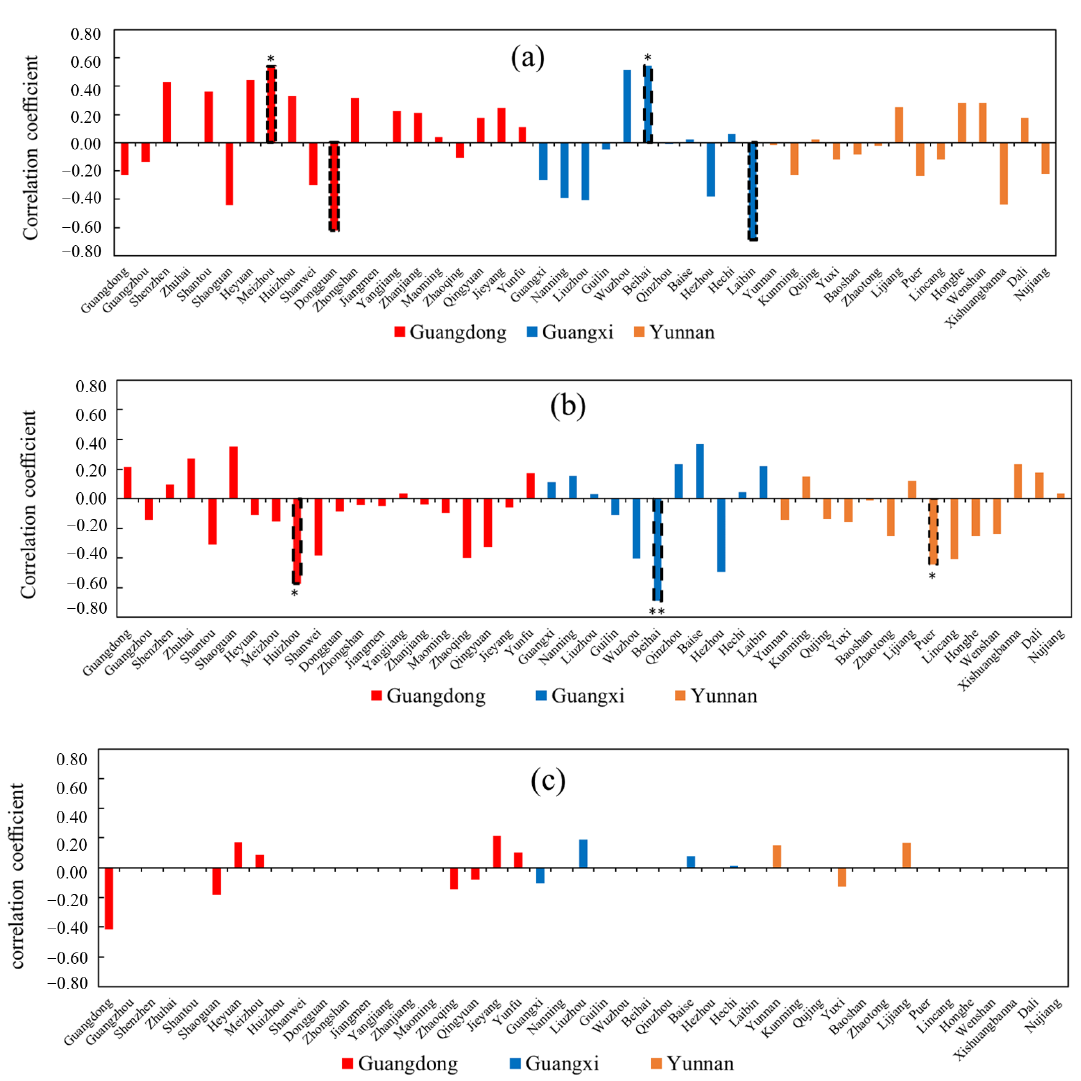
Figure 11. Correlation coefficients between sugarcane climatic yield and the intensities of drought ( a ), flood ( b ), and HT ( c ) in southern China. The black dotted boxes indicate p < 0.05. * and ** indicate p < 0.05 and p < 0.01, respectively.